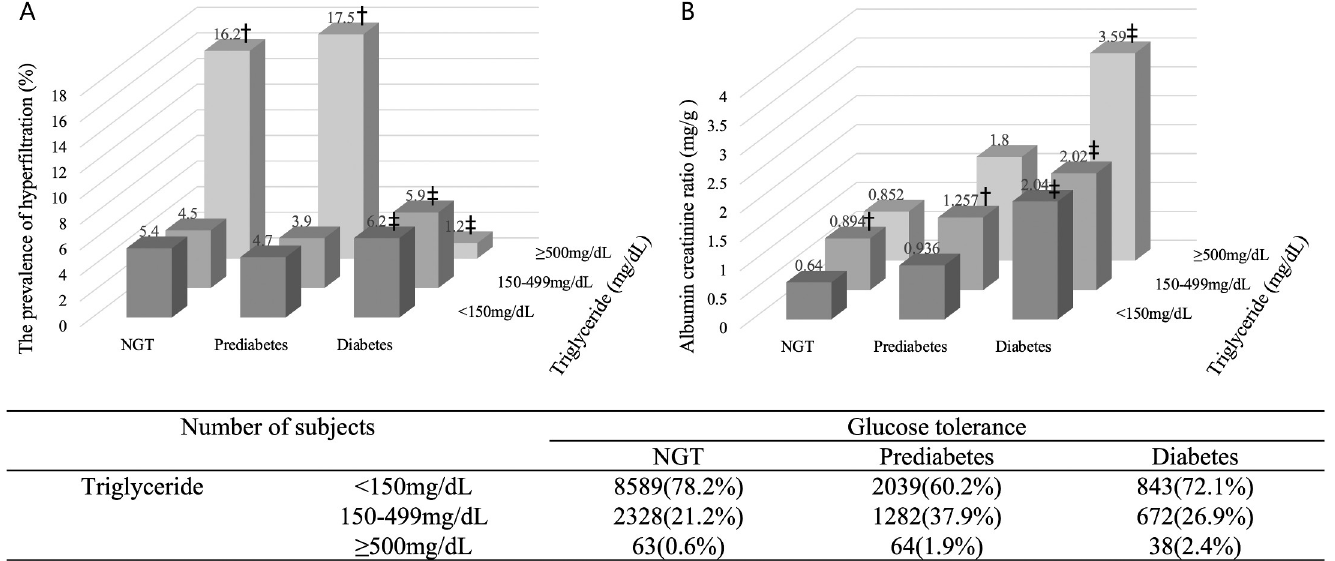
Fig 2. Prevalence of hyperfiltration by serum triglyceride level and diabetes status after adjusting for clinical and metabolic parameters � . NGT, normal glucose tolerance. � age, sex, body weight, body mass index, waist circumference, systolic blood pressure, and energy intake. † P < 0.05 vs. a serum triglyceride level < 150 mg/ dL (Bonferroni method). ‡ P < 0.05 vs. Normal glucose tolerance (Bonferroni method).